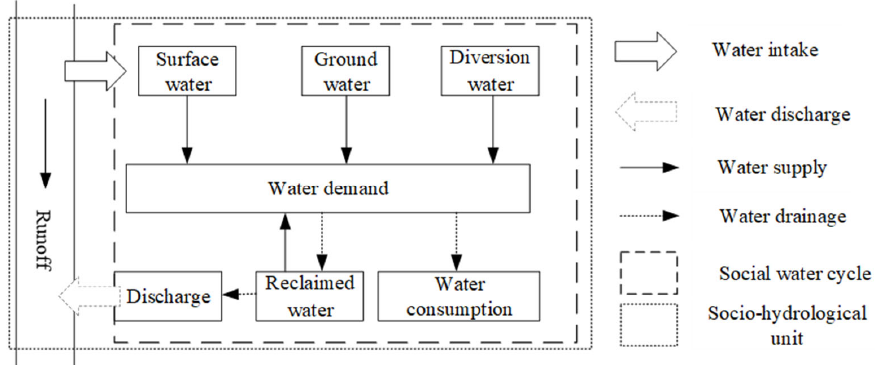
Figure 3. Mutual feedback mechanism of natural and social water cycles in each unit.